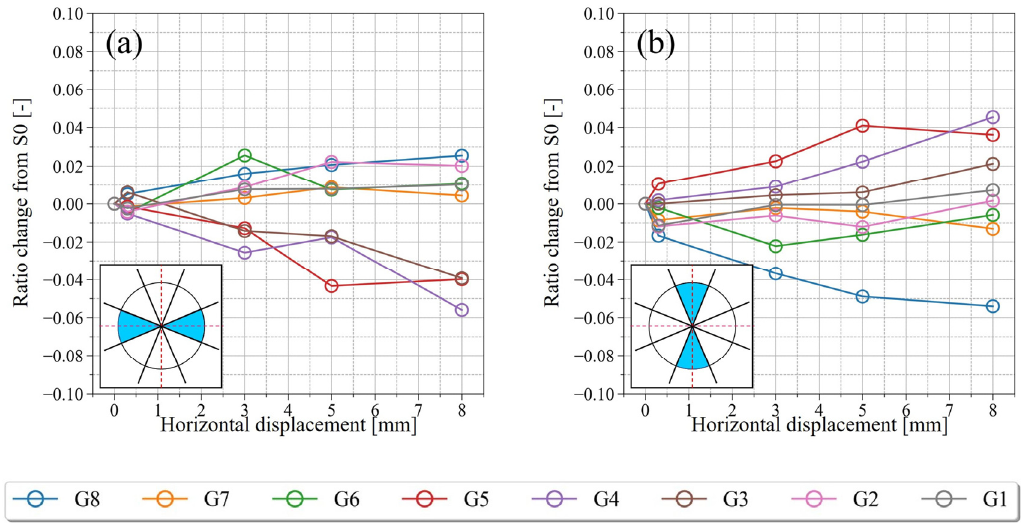
Figure 18. Variation in the ratio of the particle’s long axis from S0 (initial state). ( a ) 337.5–22.5 ° and 157.5–202.5 ° , and ( b ) 67.5–112.5 ° and 247.5–292.5 ° .